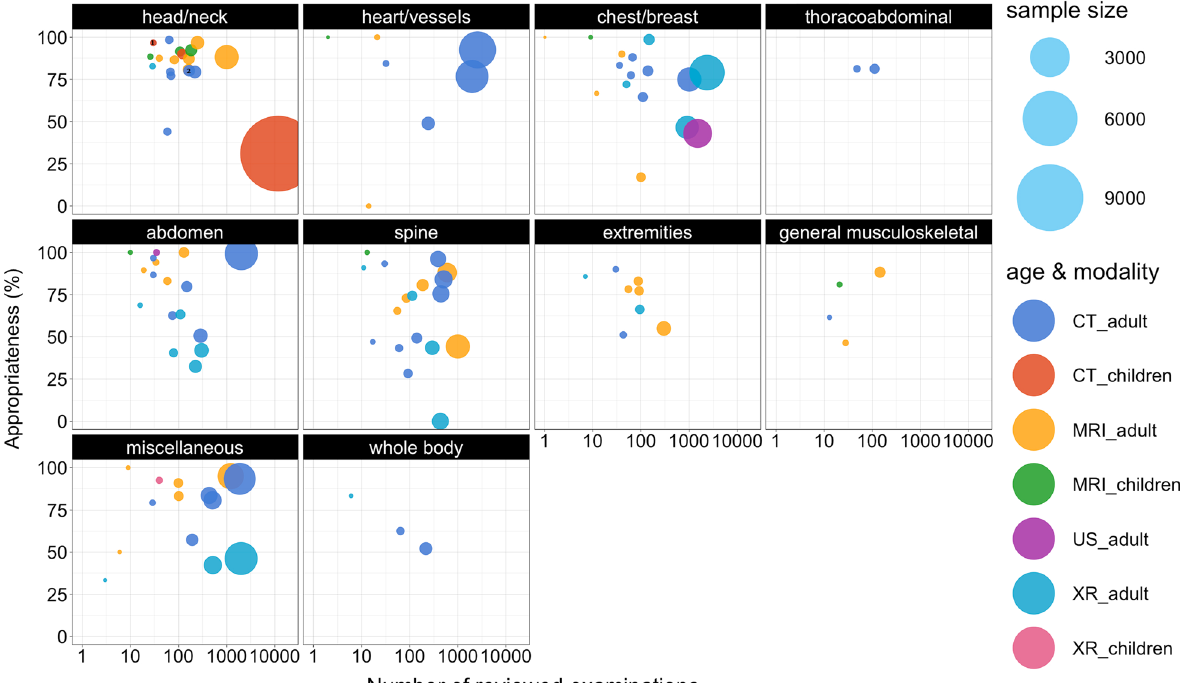
Fig. 2 Bubble plot of study‑individual appropriateness and number of reviewed examinations. The Bubble plot shows a matrix of study‑individual appropriateness results (y‑axis) and the number of reviewed examinations (x‑axis). The age‑stratified (adult, children) results were separately presented according to the aggregated body regions chest/abdomen/pelvis, chest/breast, general musculoskeletal (MSK)/extremities, head/neck, heart/vessels, other/miscellaneous, spine and whole body. Interventional studies are highlighted with black circles. Four studies reviewing the appropriateness of imaging other/miscellaneous body regions (CT MRI) [64], heart/vessels CT [86], chest/breast CT [65] and whole body CT [89] + were not included into the bubble plot due to missing information on the number of reviewed images. 1: Identical study results [100] of children and adult CT lead to a total overlap of bubbles in head/neck imaging. 2: Similar study results of adult MRI [93, 101] and adult CT [75] lead to a partial overlap of bubbles in head/neck imaging. CT Computed tomography. MRI Magnetic resonance imaging. MSK Musculoskeletal. US Ultrasound. XR